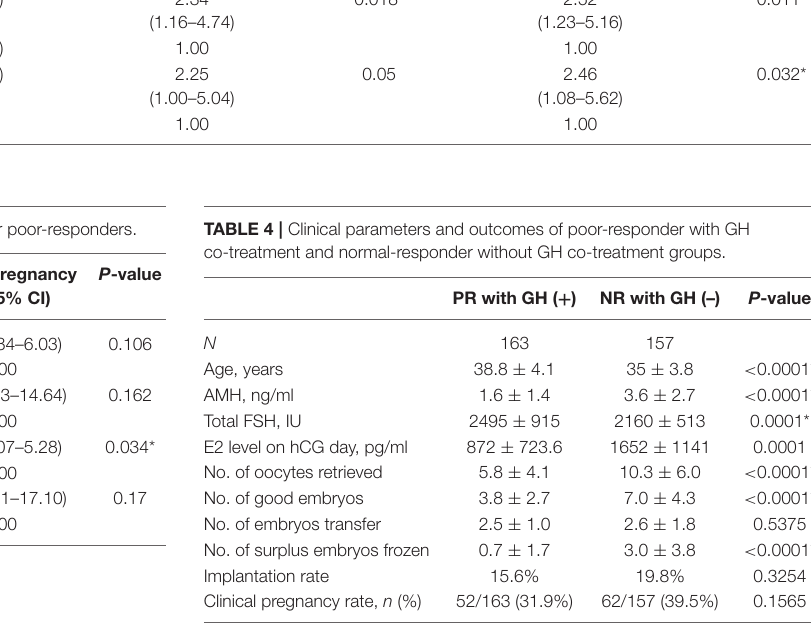
Clinical pregnancy OR (95% CI) rate, N (%) P -value Univariable analysis (Crude OR)